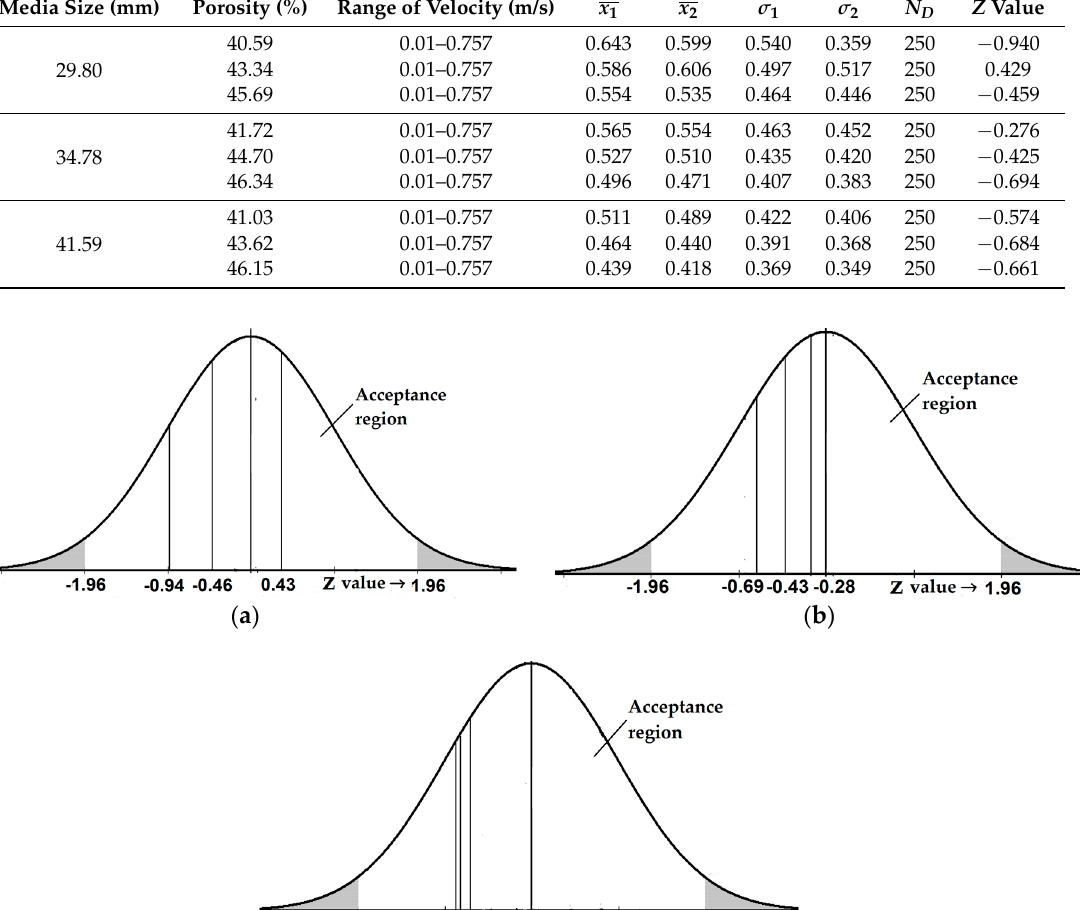
Table 5. Values from the Z -test for different media sizes and porosities.